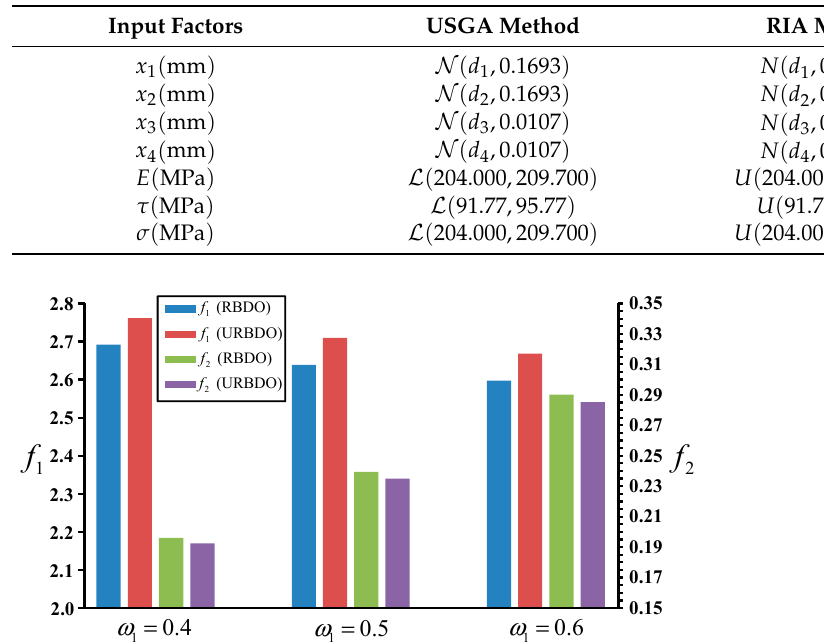
Table 5. Distribution parameters of input factors.